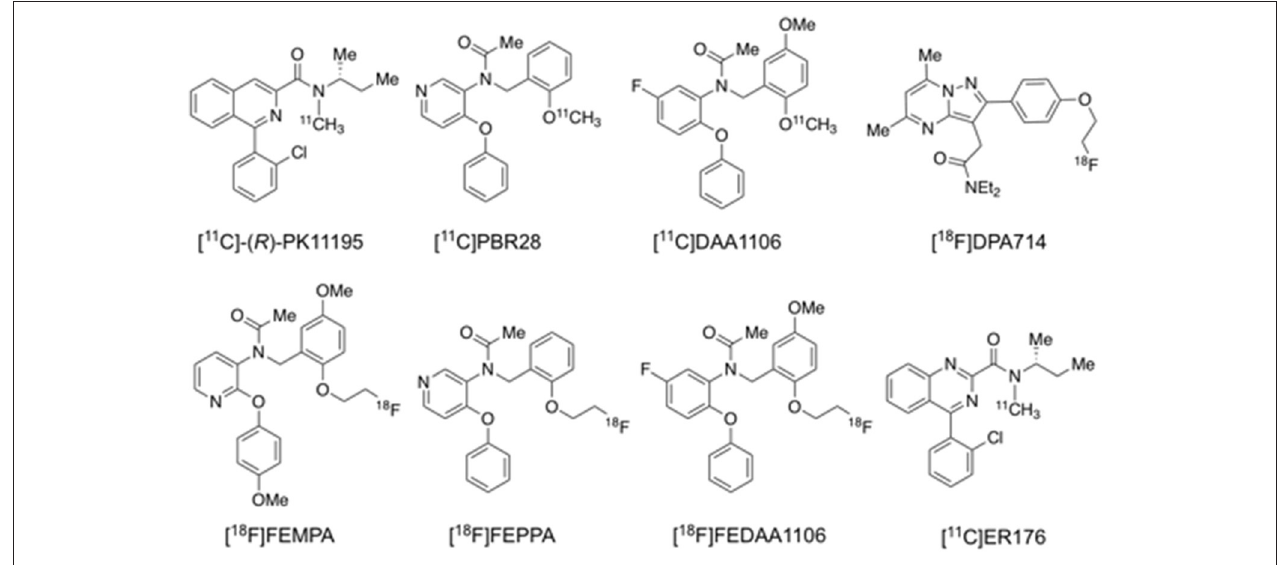
FIGURE 4 | Structures of representative PET radiotracers for TSPO imaging.